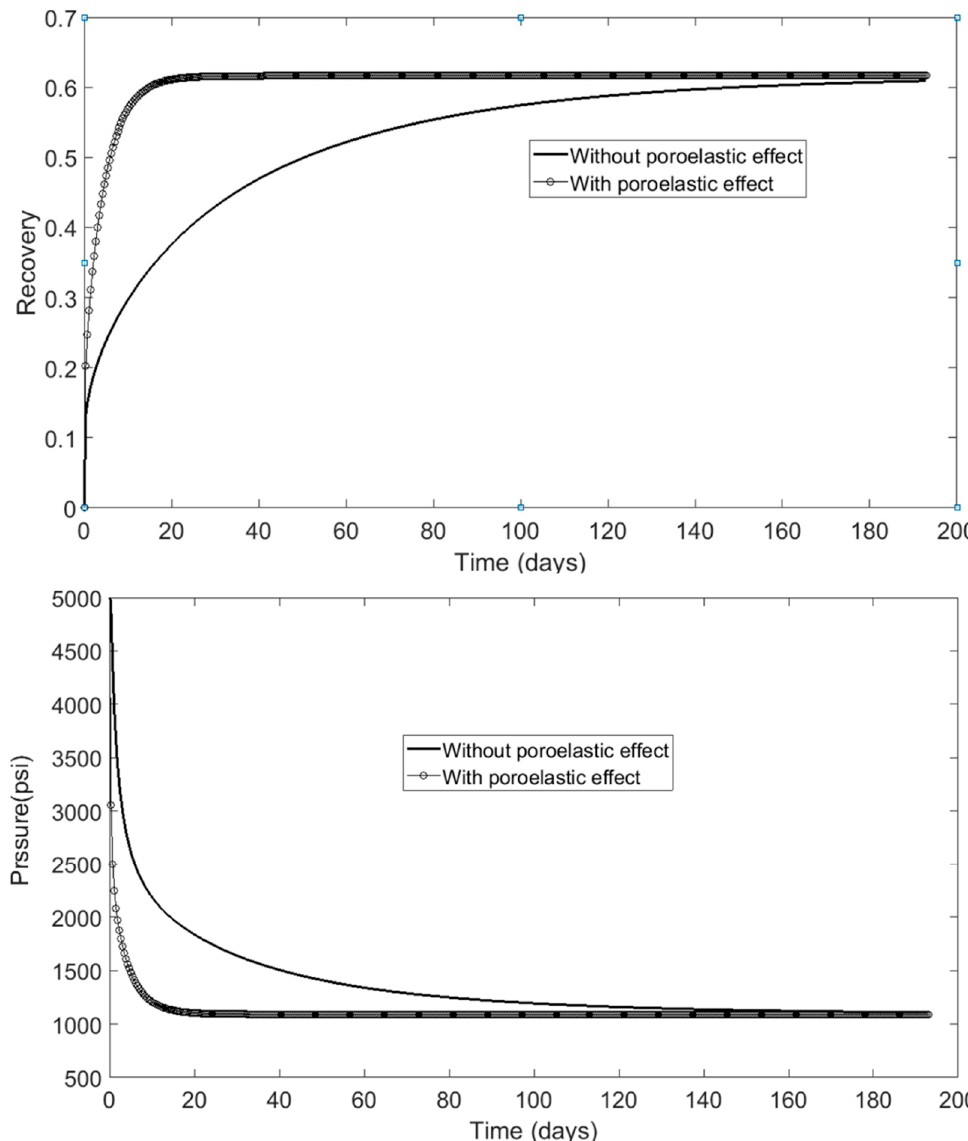
Figure 4. Pressure decay ( bottom ) and ultimate recovery ( top ) comparisons of models with and without poroelastic effect.